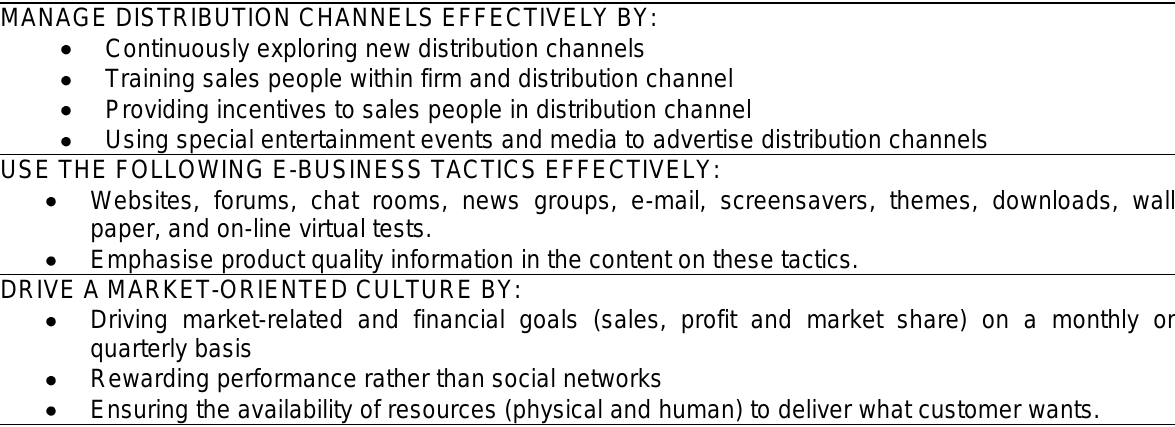
Table 8: a generic model to increase sales growth in the motorcar, high-Technology and food manufacturing